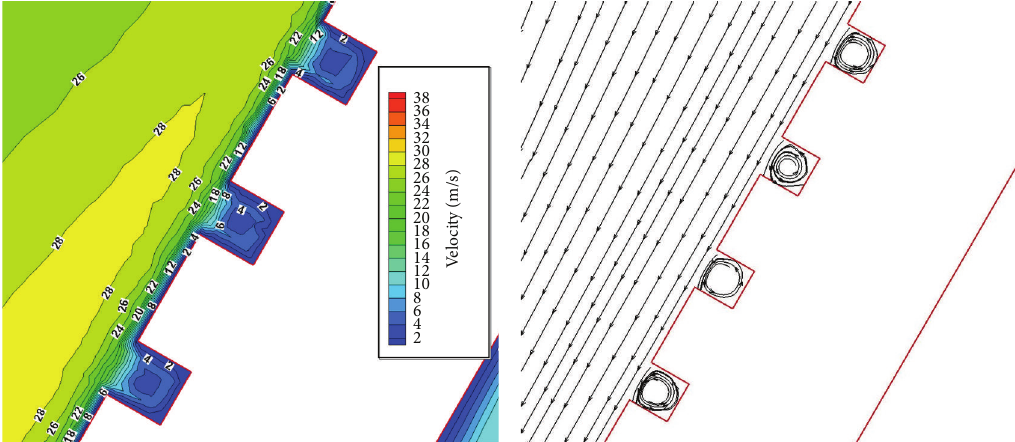
Figure 6: Flow velocity contours and path lines of the surface region of groove